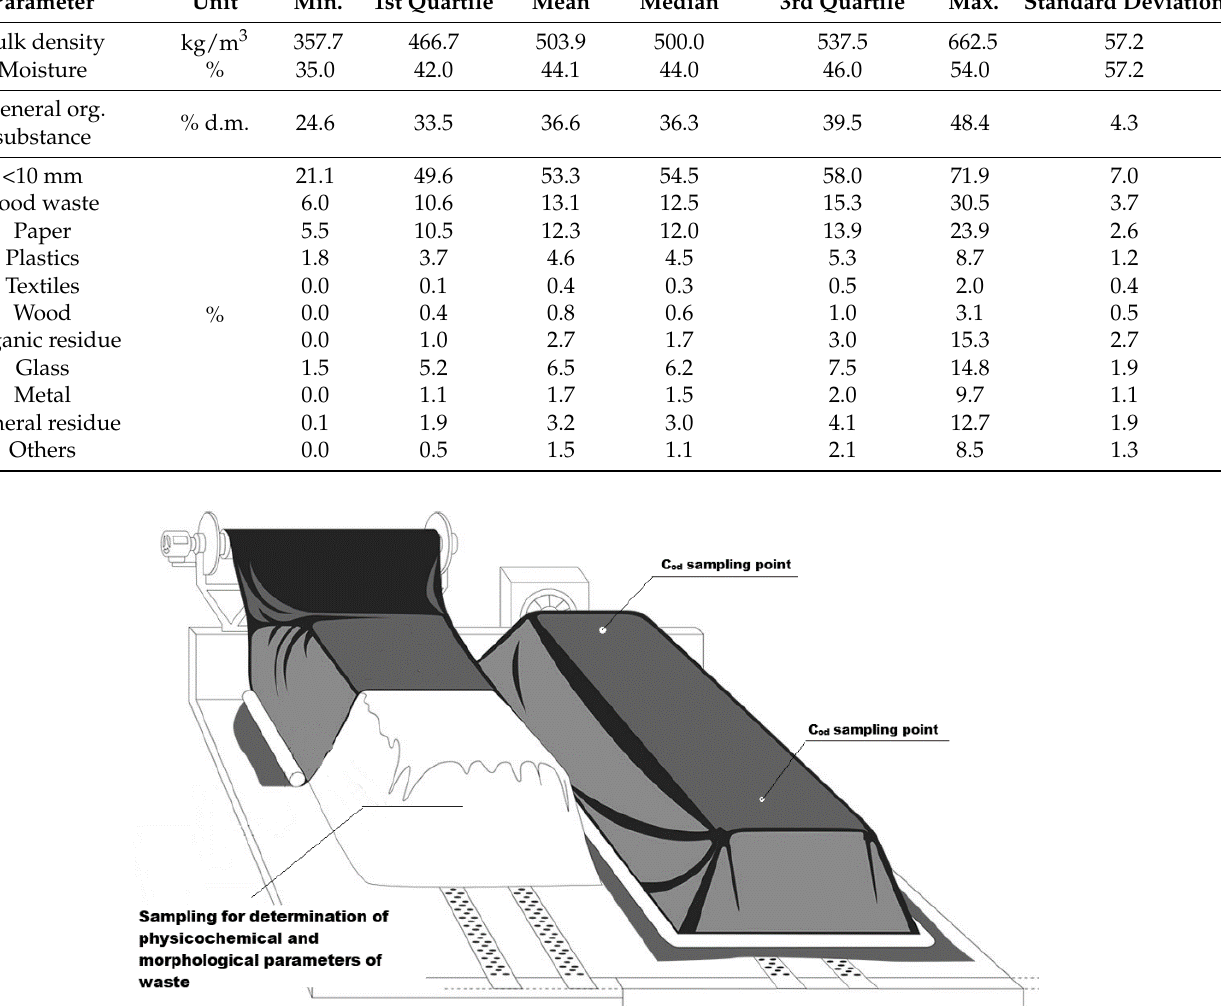
Figure 1. Scheme of covered windrows with sampling points (based on: https://www.gore.com/resources/principle-of-organic-waste-treatment-gore-cover, accessed on 16 February 2021).